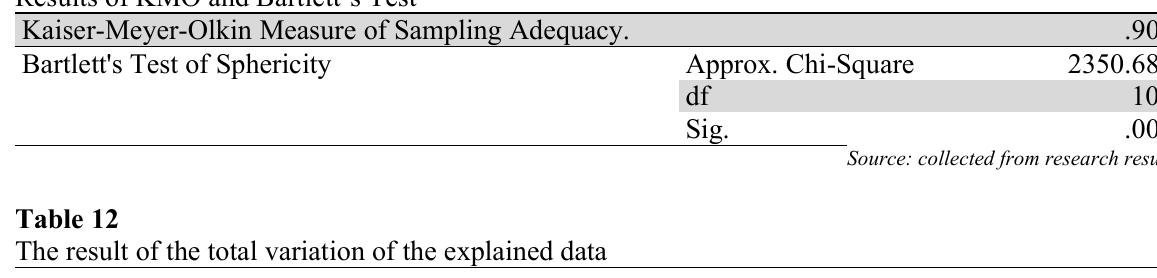
The result of the total variation of the explained data Initial Eigenvalues Extraction Sums of Squared Loadings Rotation Sums of Squared Compo- nent